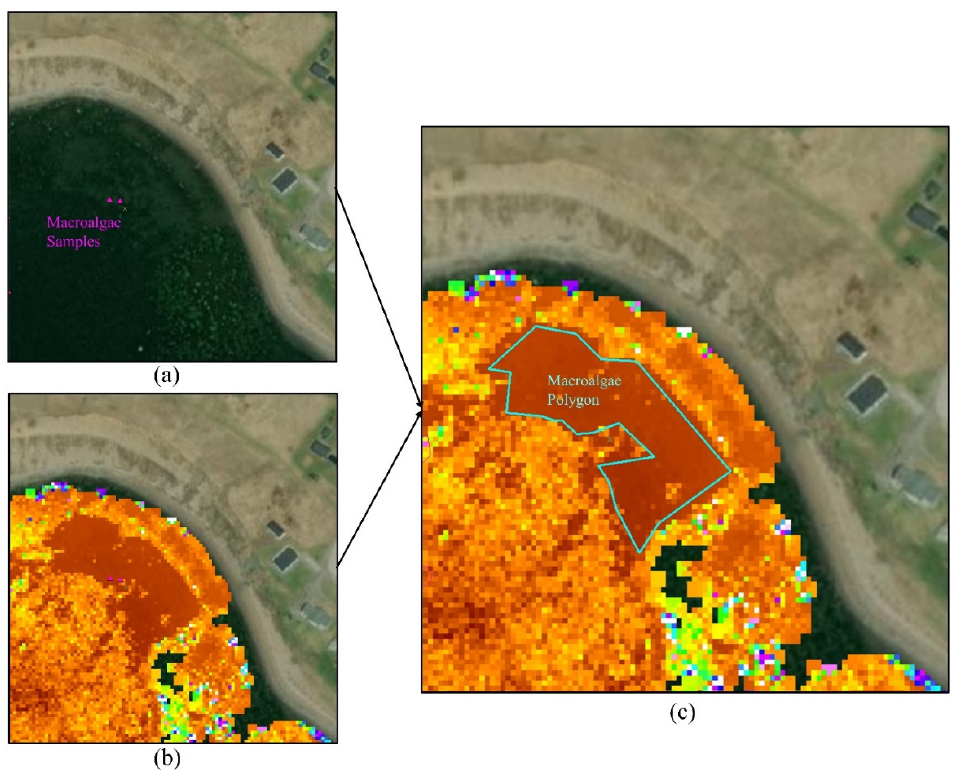
Figure 3. The procedure of converting the in situ sample points to the GIS polygons: ( a ) two in situ samples of Macroalgae overlaid on the high-resolution Google Earth imagery; ( b ) the same region in the LiDAR intensity image; ( c ) the generated polygon for these two samples in the ArcGIS software.